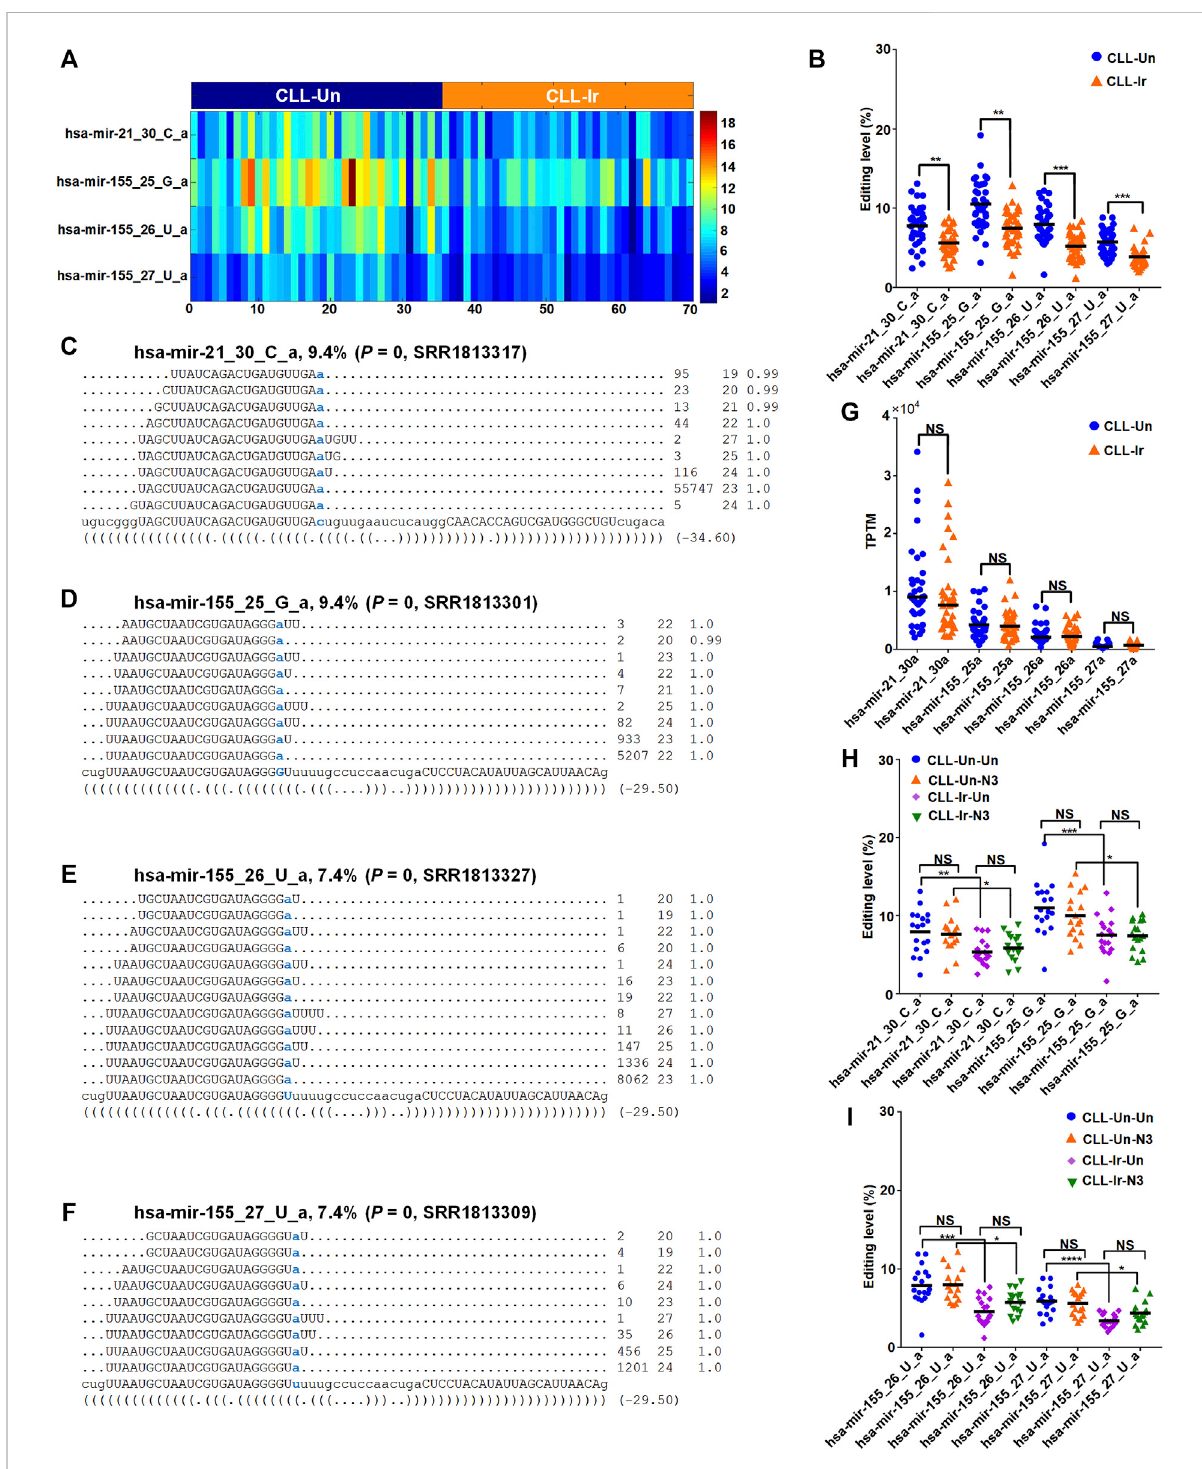
FIGURE 4 Four M/E sites with signi fi cantly different editing levels in CLL (A) The editing levels of this 4 M/E sites with signi fi cantly different in the 70 selected sRNA-seq pro fi les. (B) The editing levels of 4 M/E sites with signi fi cantly different present in CLL-Ir and CLL-Un samples (C — F) The detailed reads of hsa-mir-21_30_C_a in one of the CLL-Un samples (SRR1813317), hsa-mir-155_25_G_a in one of the CLL-Un samples (SRR1813301), hsa-mir-155_26_U_a in one of the CLL-Un samples (SRR1813327), and hsa-mir-155_27_U_a in one of the CLL-Un samples (SRR1813309), respectively (G) The expression levels of four edited miRNAs (hsa-mir-21_30a, hsa-mir-155_25a, hsa-mir-155_26a, and hsa-mir-